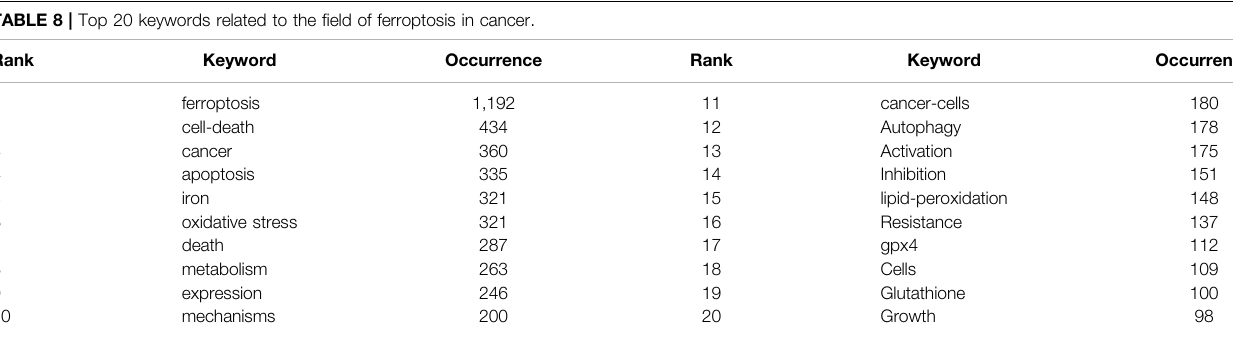
TABLE 8 | Top 20 keywords related to the fi eld of ferroptosis in cancer. Rank Keyword Occurrence Rank Keyword